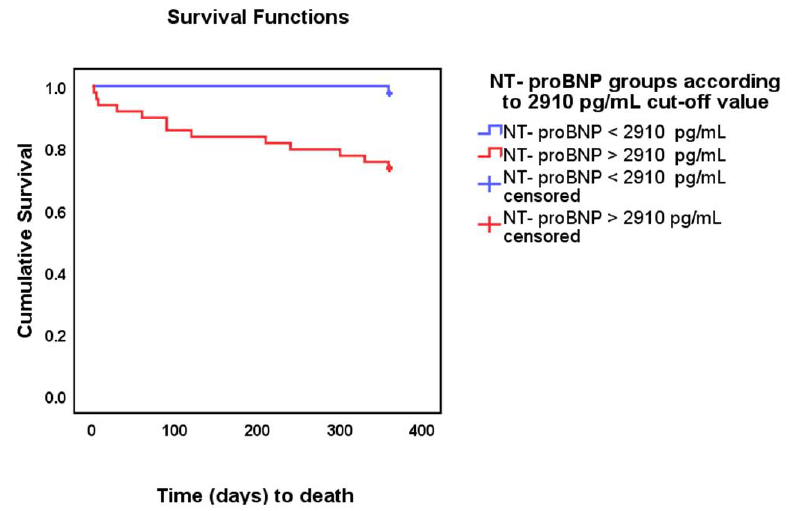
Figure 3. Survival curves for all-cause mortality at 12 months’ follow-up in patients with de novo acute Figure 3 . Survival curves for all-cause mortality at 12 months follow-up in patients with de novo hospitalised HFpEF. Kaplan–Meier cumulative survival in the two groups: NT-proBNP < 2910 pg/mL acute hospitalised HFpEF. Kaplan – Meier cumulative survival in the two groups: NT-proBNP < 2910 (blue), and NT-proBNP ≥ 2910 pg/mL (red) (time in days to pg/mL (blue), and NT- proBNP ≥ 2910 pg/mL (red) (time in days to death).